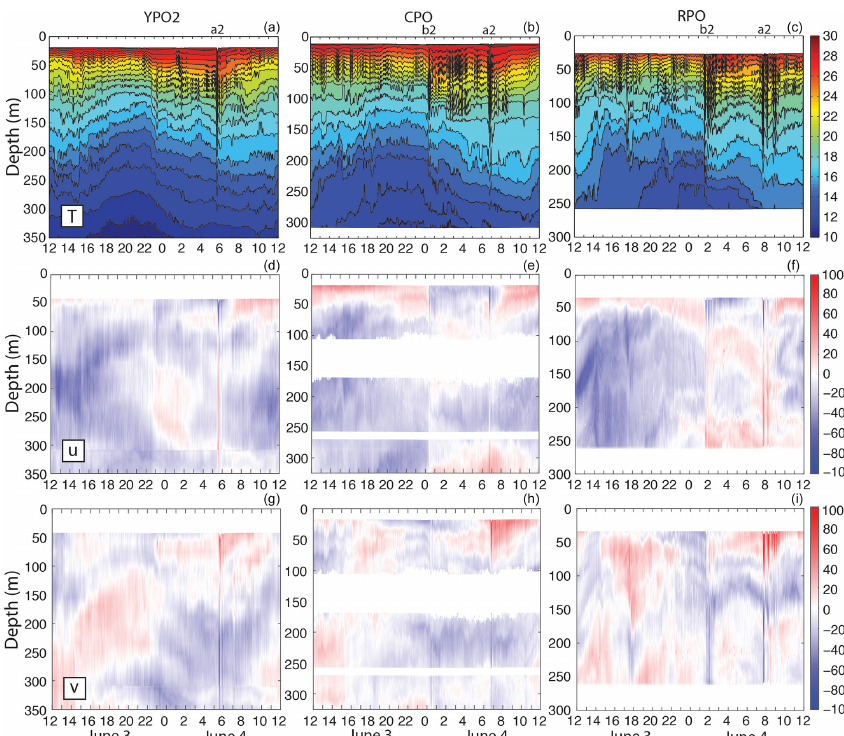
Figure 10. Temperature (a–c) , u component of velocity (d–f) and v component of velocity (g–i) from 3–4 June 2014 from moorings YPO2 (a, d, g) , CPO (b, e, h) , and RPO (c, f, i) . The wave propagation time between moorings was 67min from YPO2 to CPO and 56min from CPO to RPO. Positive ( u , v ) represents (east, north) respectively. White space at mooring CPO indicates regions not sampled by the three ADCPs. These data were obtained during a period of moderate and declining tidal forcing; see Figs. 3 and 5 for